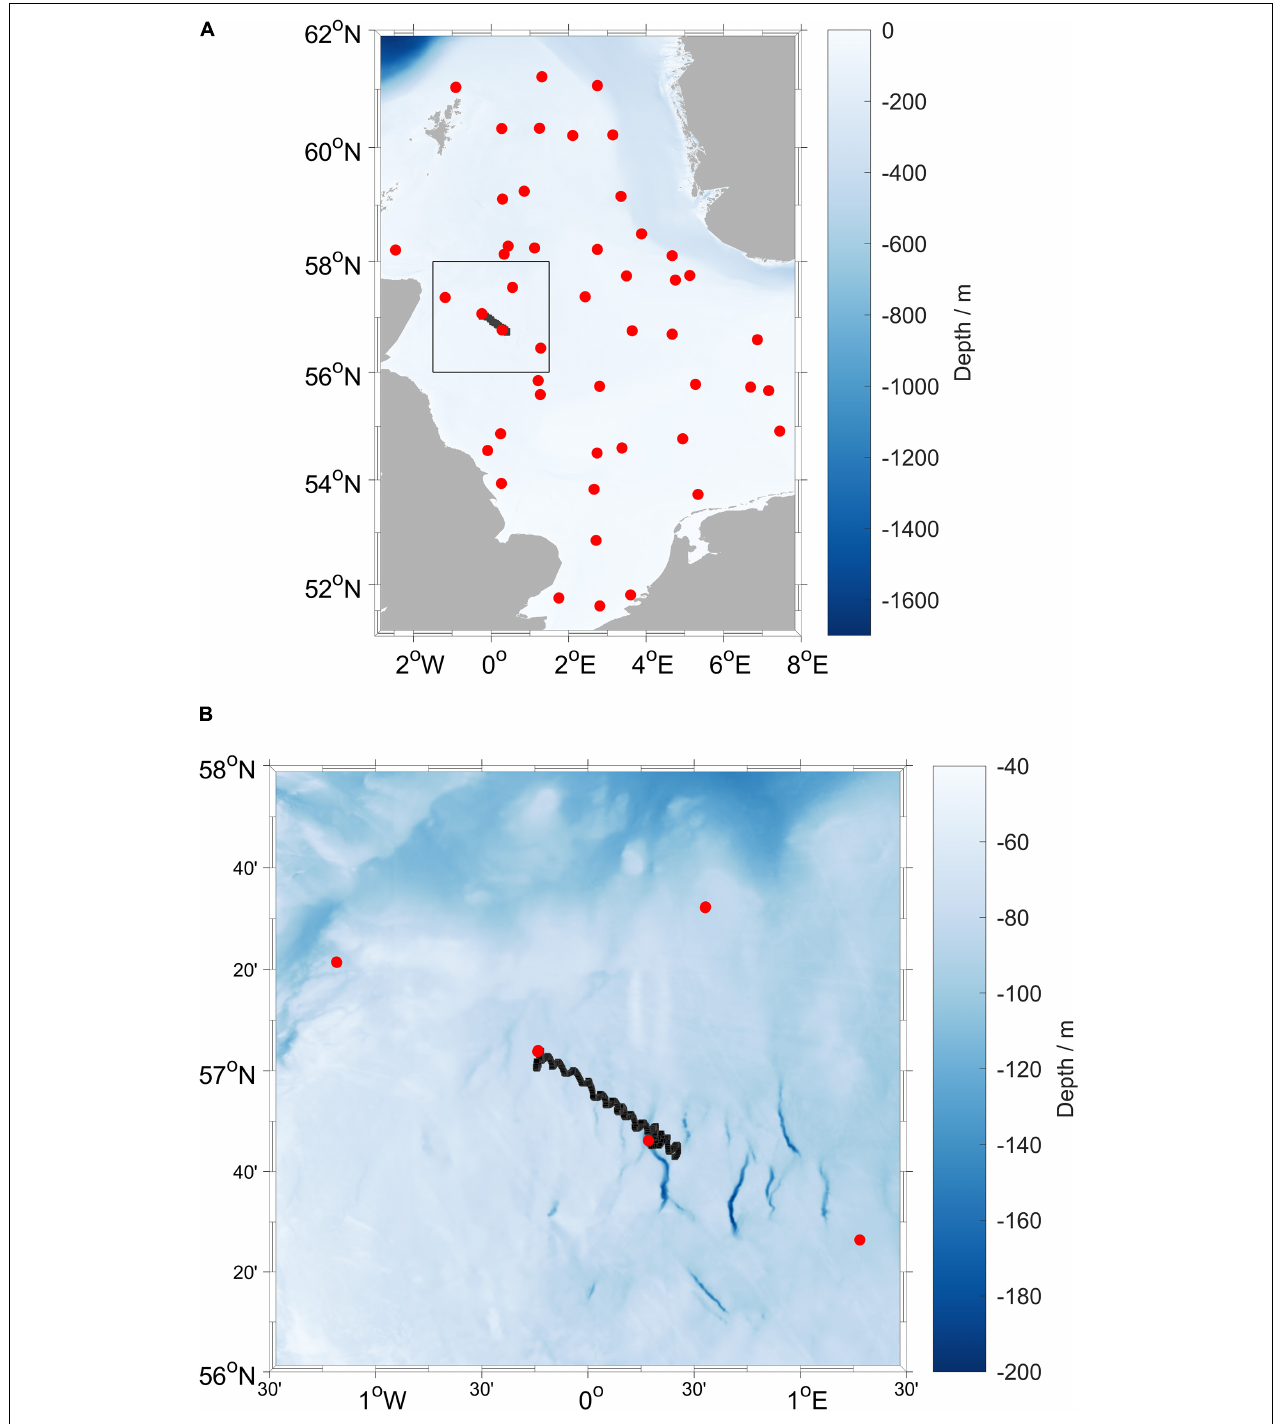
FIGURE 1 | (A) Map of the North Sea, with the black box indicating (B) the location of the deployment area with glider positions from 19 to 29 August 2019 (black line) and CTD stations (red points) occupied during RV Cefas Endeavour survey CEND 12/19 (7 August to 5 September 2019).